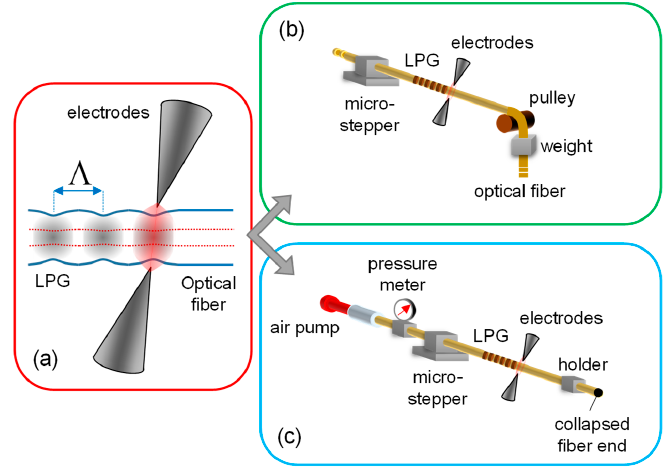
Figure 1. Schematic of Electric Arc Discharge (EAD) fabrication setup: ( a ) details of electrodes and tapered fiber; ( b ) configuration for solid silica fibers; ( c ) configuration for hollow core fibers.